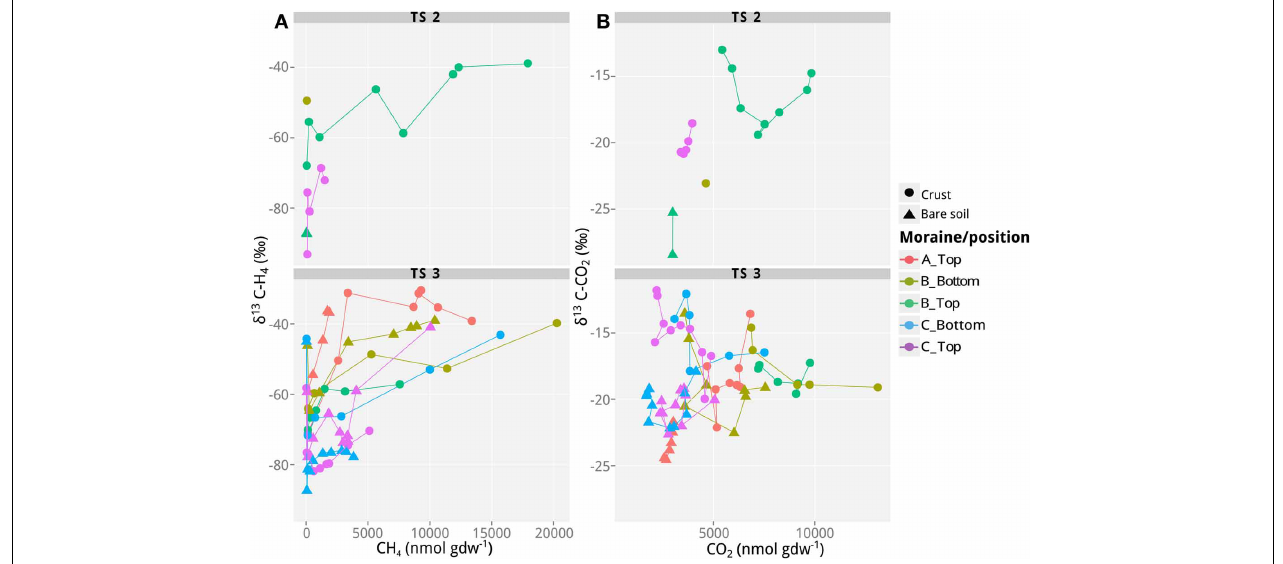
FIGURE 2 | Values of δ 13 C of CH 4 and CO 2 as a function of CH 4 and CO 2 concentrations in incubations with soil samples from the different lateral moraines in Tsomoriri Plains. (A) δ 13 C of CH 4 and (B) δ 13 C of CO 2 . Only samples producing > 40nmol